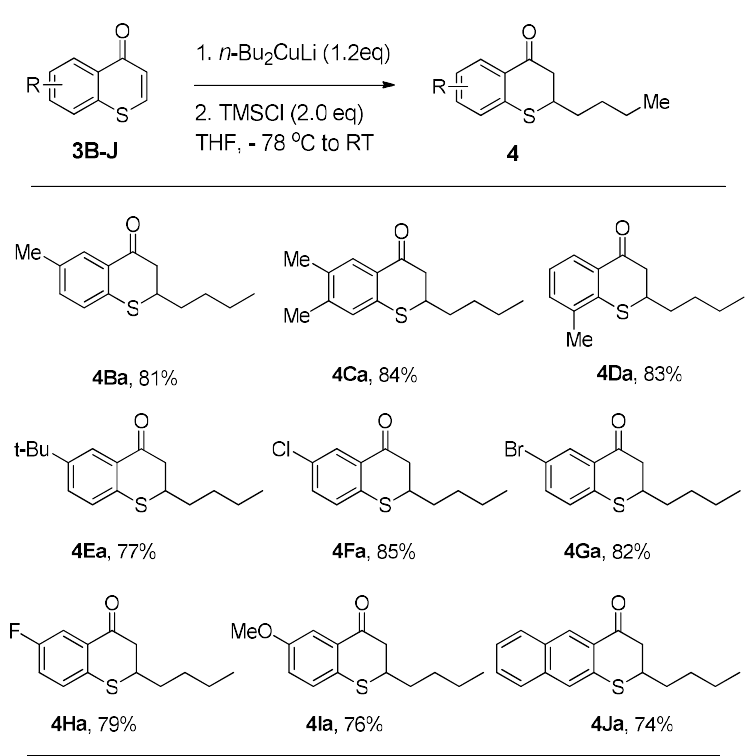
Scheme 3. Reactions of Lithium di- n -butylcuprates with Substitututed Thiochromones. a. All